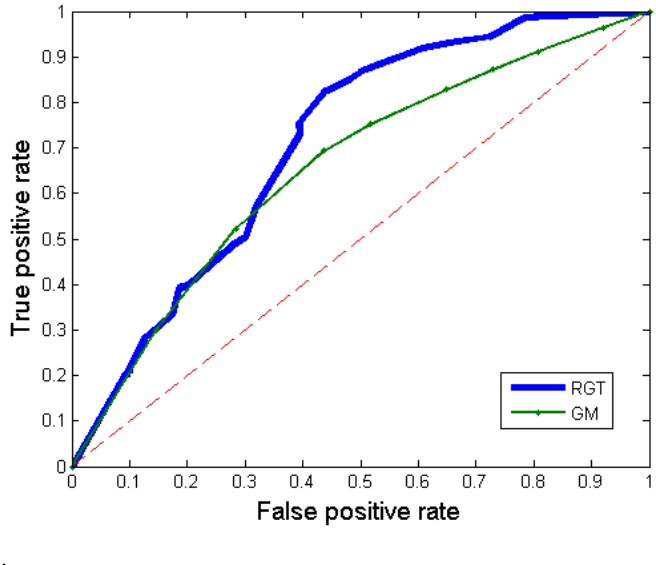
Figure 13. ROC curve of our method (parameter T ) and Gaussian mixture (parameter T g ) for all the tested